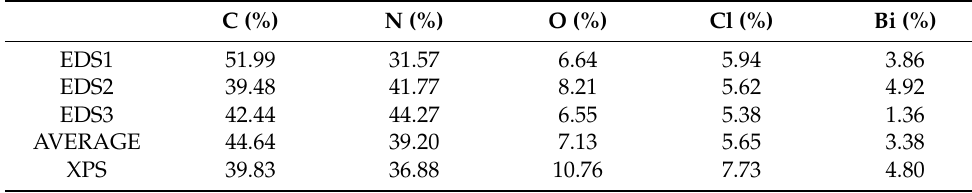
Figure 6. EDS and elemental mapping of CB-3: ( a ) EDS, ( b ) overlap, ( c ) C, ( d ) N, ( e ) Cl, ( f ) Bi, and ( g ) O. Table 1. Atomic concentration determined by XPS and EDS .